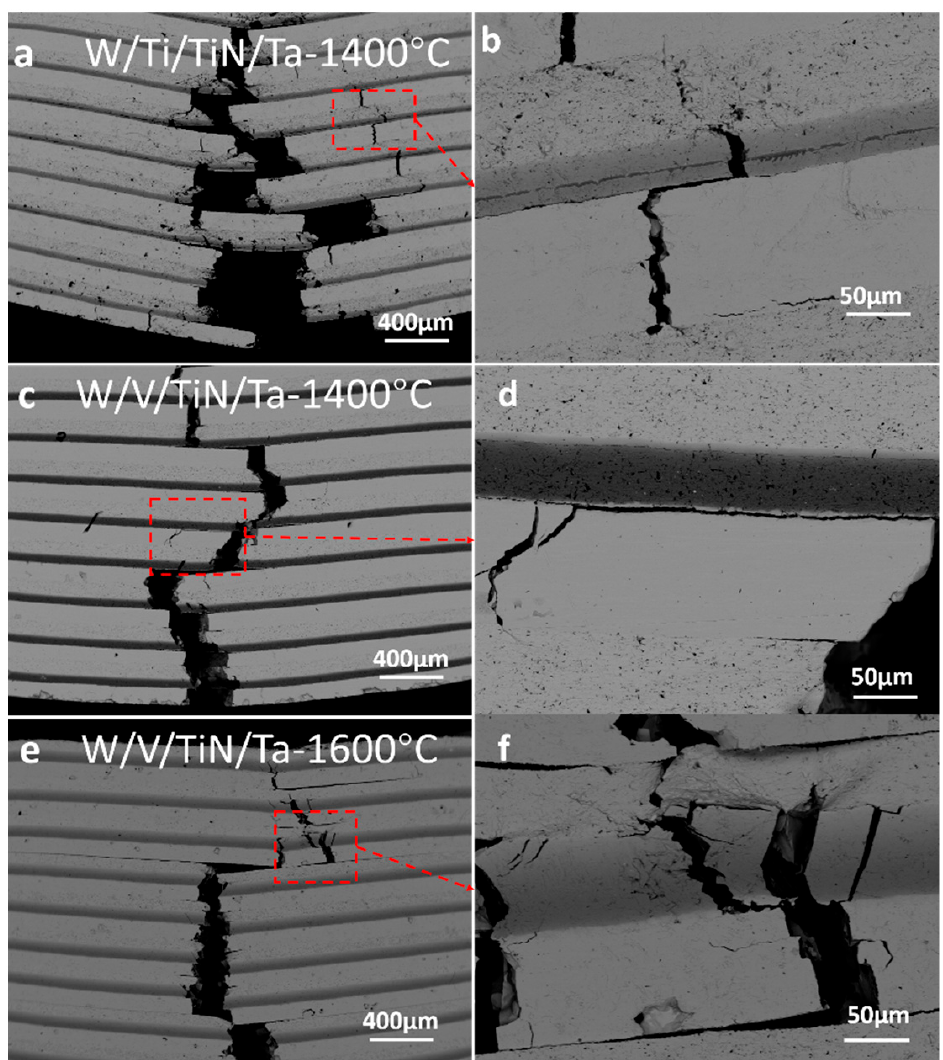
Figure 13. Three-point bending crack distribution of W/M/TiN/Ta-laminated composites with different transition metal layers after SPS: ( a , b ) W/Ti/TiN/Ta (1400 °C); ( c , d ) W/V/TiN/Ta (1400 °C); and ( e , f ) W/V/TiN/Ta (1600 °C).